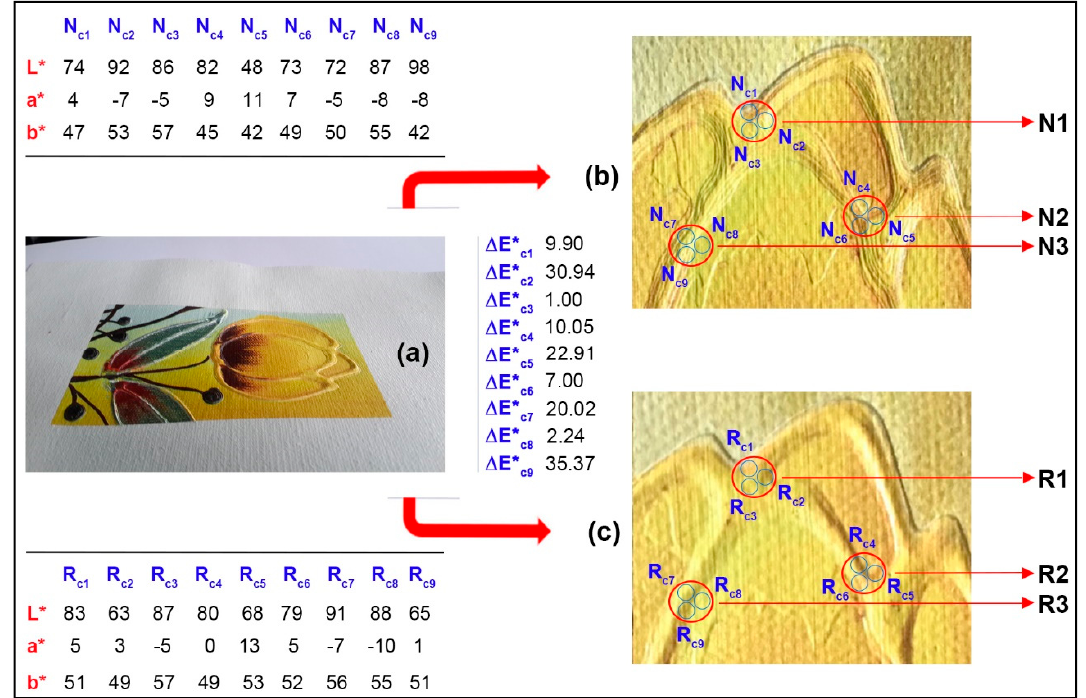
Figure 6. Local block comparison of two oil painting replicas: ( a ) complete sample; ( b ) a local block of normal-sequence sample; ( c ) a local block of reverse-sequence sample.